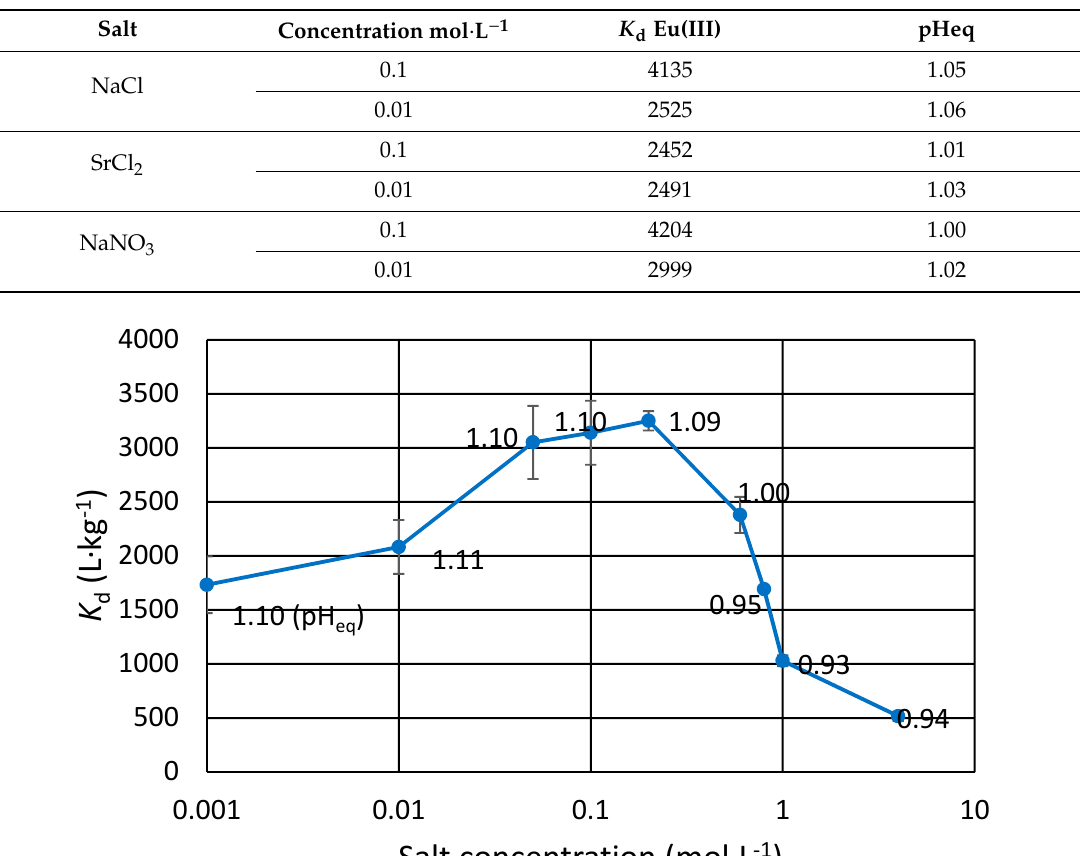
Table 2. Comparison of the e ff ect of Na(I) and Sr(II) concentration on Eu(III) distribution coe ffi cient in nitric acid for ZrP.